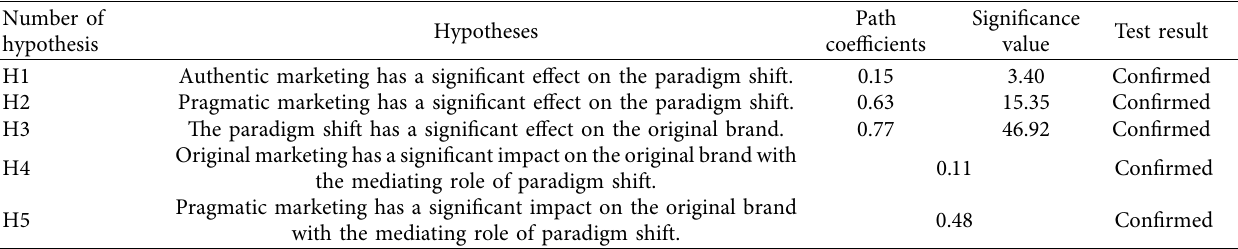
Table 7: Results of partial least squares analysis for first-order research hypotheses.